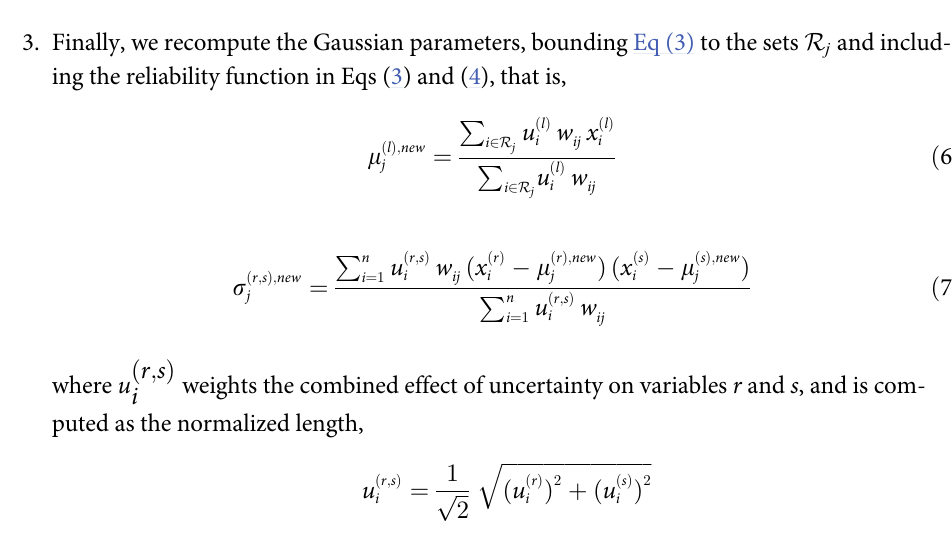
or R , hence they LL HH